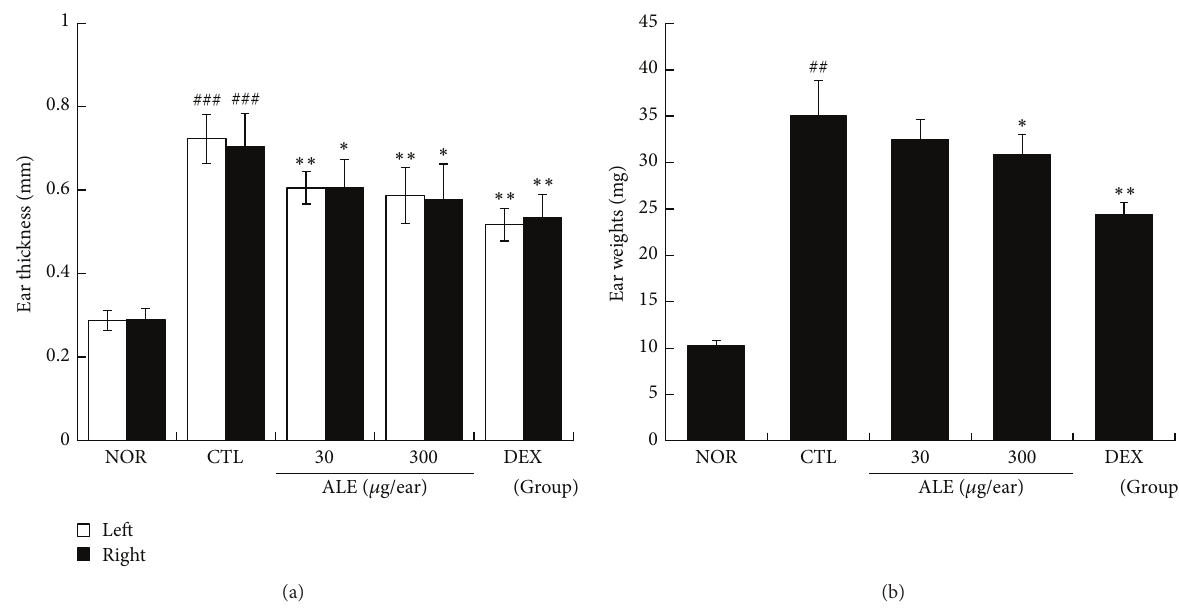
Figure 2: Effect of ALE on ear swelling in CD mice. The ear thickness and weight were measured on day 15. NOR: nontreated normal; CTL: nontreated CD; 30 or 300, 30, or 300 𝜇 g/ear of ALE; DEX: 75 𝜇 g/ear of DEX. (a) Ear thickness. (b) Ear weight. Values are presented as the means ± SD. ## 𝑃 < 0.01 and ### 𝑃 < 0.001 compared to the NOR group and ∗ 𝑃 < 0.05 and ∗∗ 𝑃 < 0.01 compared to the CTL